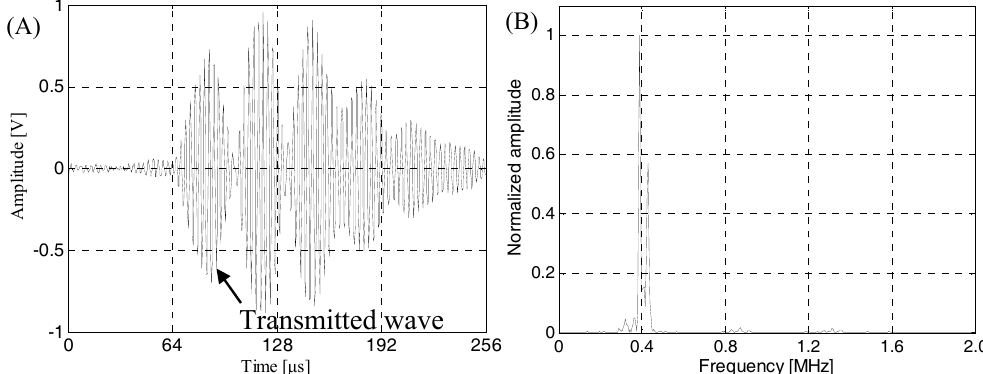
Figure 19. Air-coupled ultrasonic signal and its frequency spectrum during actual detection. ( A ) The transmission signal; ( B ) The corresponding frequency spectrum.